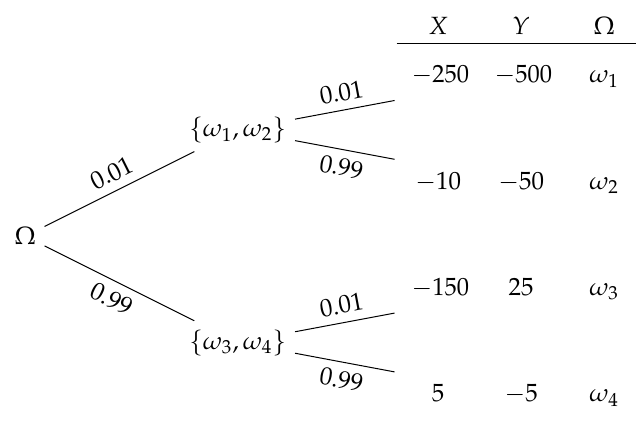
Figure 1. Distributions of X and Y (Example